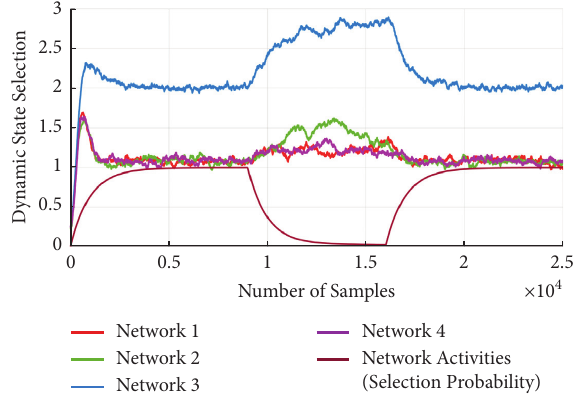
Figure 14: Effect of threshold on network connectivity for threshold � 2 ( S l � 1).